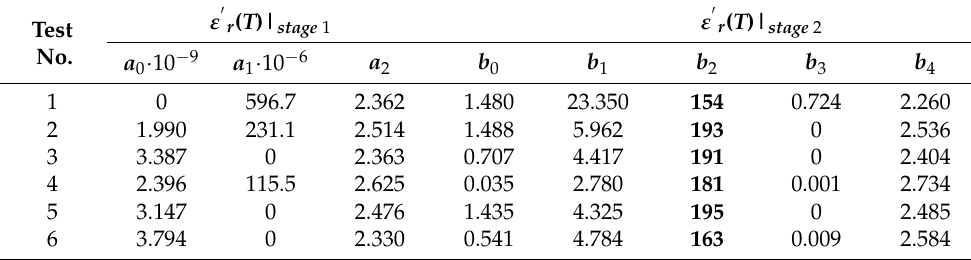
Table 3. Fitting curve parameters for the loss factor model described by Equation Table 2. Fitting curve parameters for the dielectric constant model described by Equation (5).